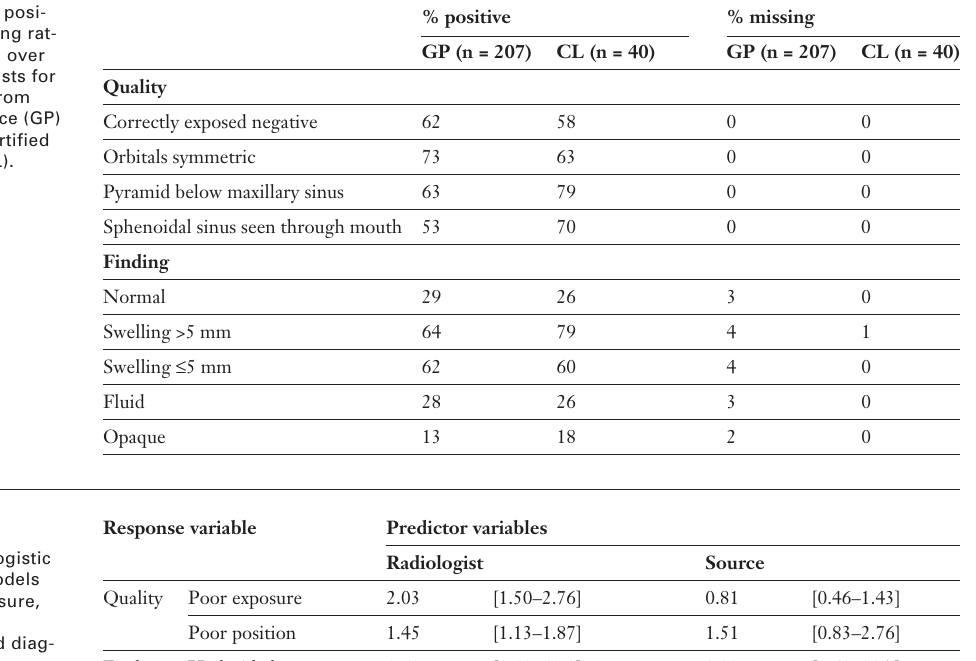
Percentage of posi- tive and missing rat- ings averaged over both radiologists for radiographs from general practice (GP) and from a certified laboratory (CL).